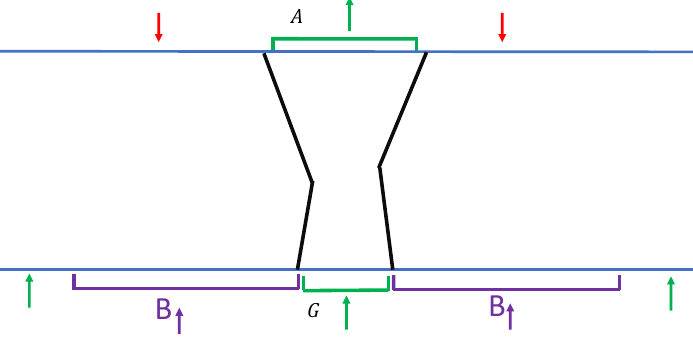
( t ) in the case where the initial O α